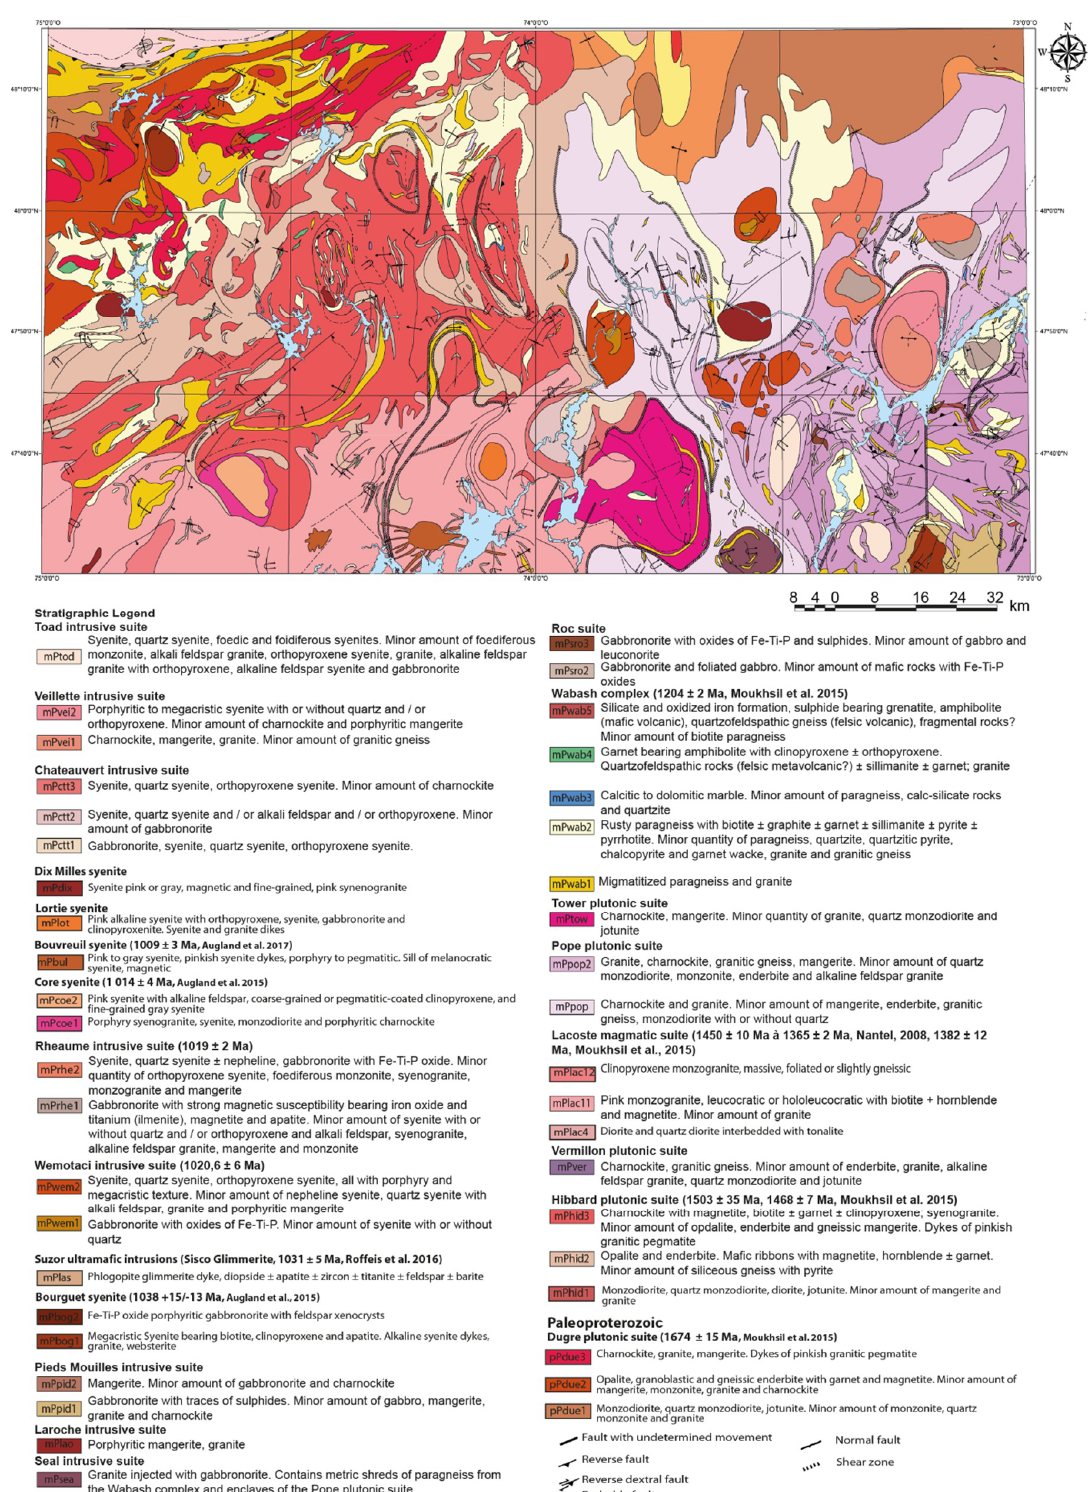
Figure 2. Local detailed geology showing the study area in the Wemotaci and Parent regions, Quebec, Canada. The mapping of this part was done in 2014 and 2016 [2,4]. Canada. The mapping of this part was done in 2014 and 2016